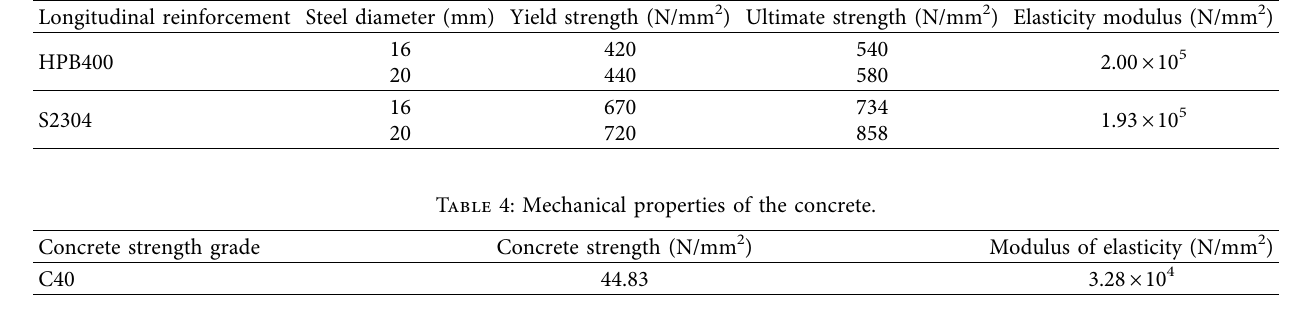
Table 3: Performance of the steel bar material.